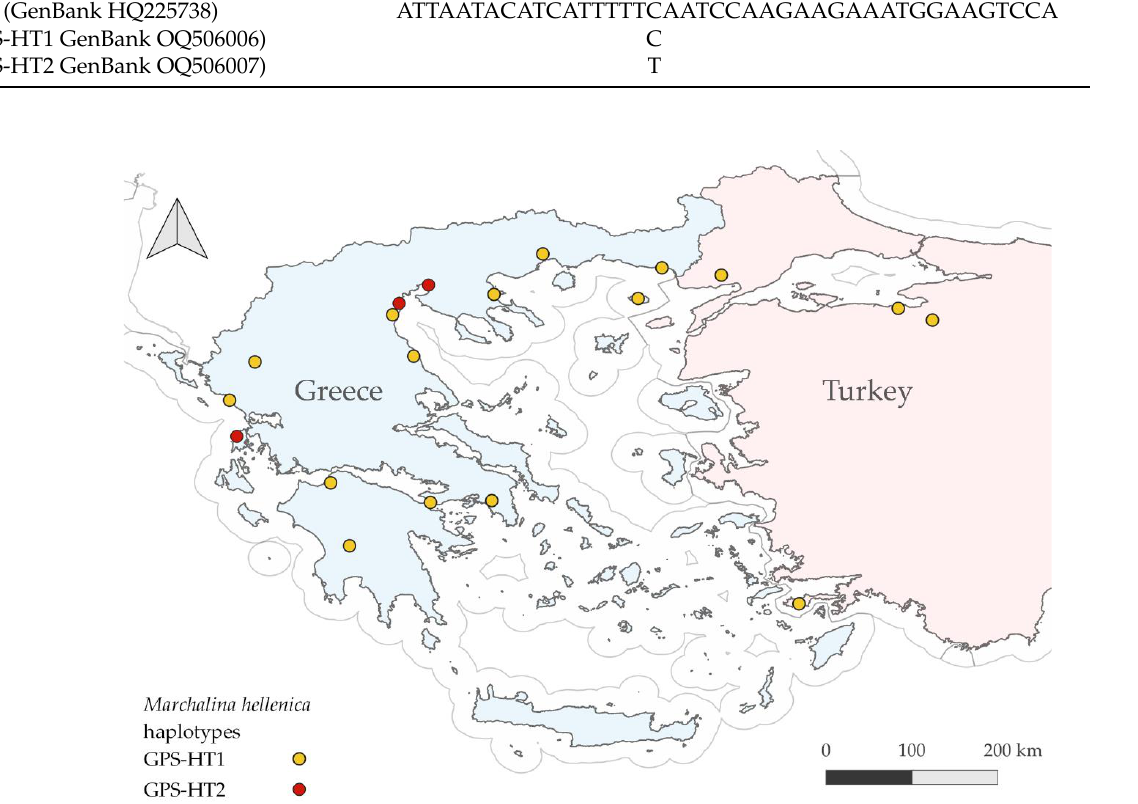
Table 1. COI mtDNA sequence of two haplotypes revealed in M. hellenica (Giant Pine Scale (GPS)) populations from Greece and Turkey.